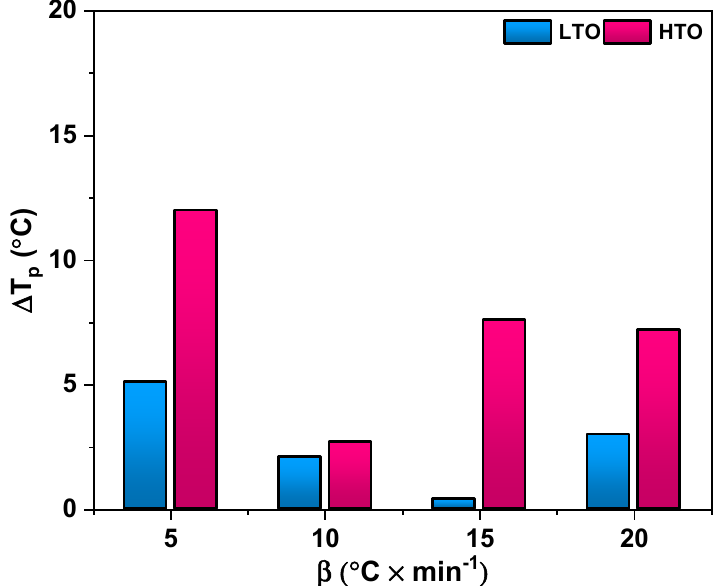
Figure 4. Differences between the peak temperatures ( ∆ Tp) of non-catalytic and catalytic peat oxidation for low- and high-temperature regions at different heating rates obtained from differential scanning calorimetric data.